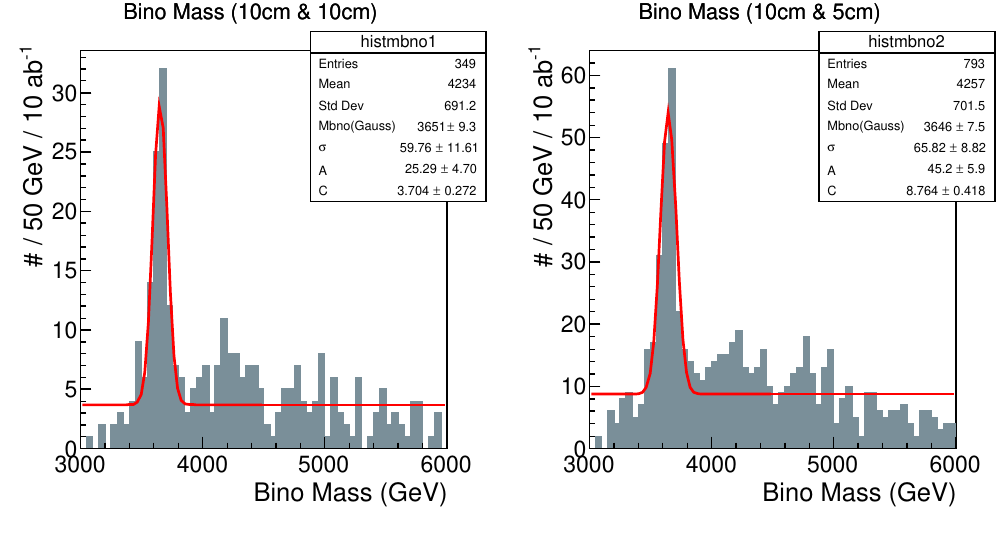
Figure 7 . Distribution of m (rec) in a single experiment with the integrated luminosity of L = 10 ab (cid:0) 1